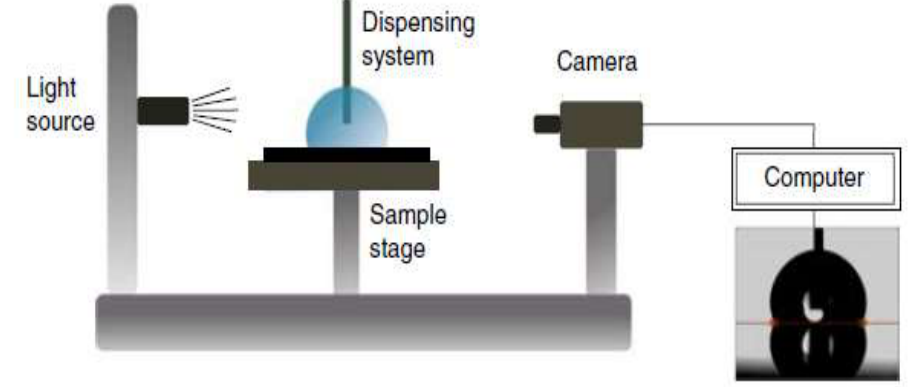
Fig.1: Process of contact